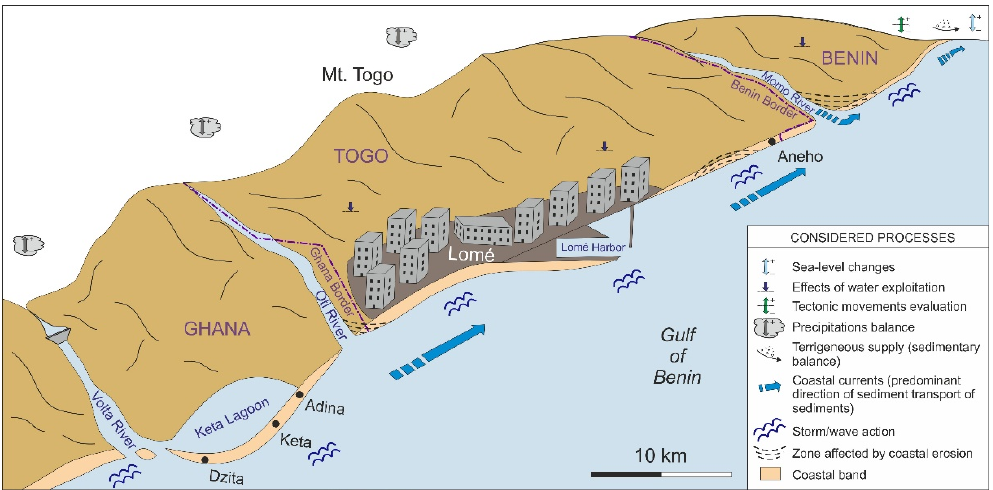
Figure 5. Sketch of the coastal strip studied (east Ghana-Togo-west Benin) with evidenced some processes that control the coastal evolution. Seaward-directed flows (not shown in Figure) may also occur to favor the onshore to offshore transport of sediments.